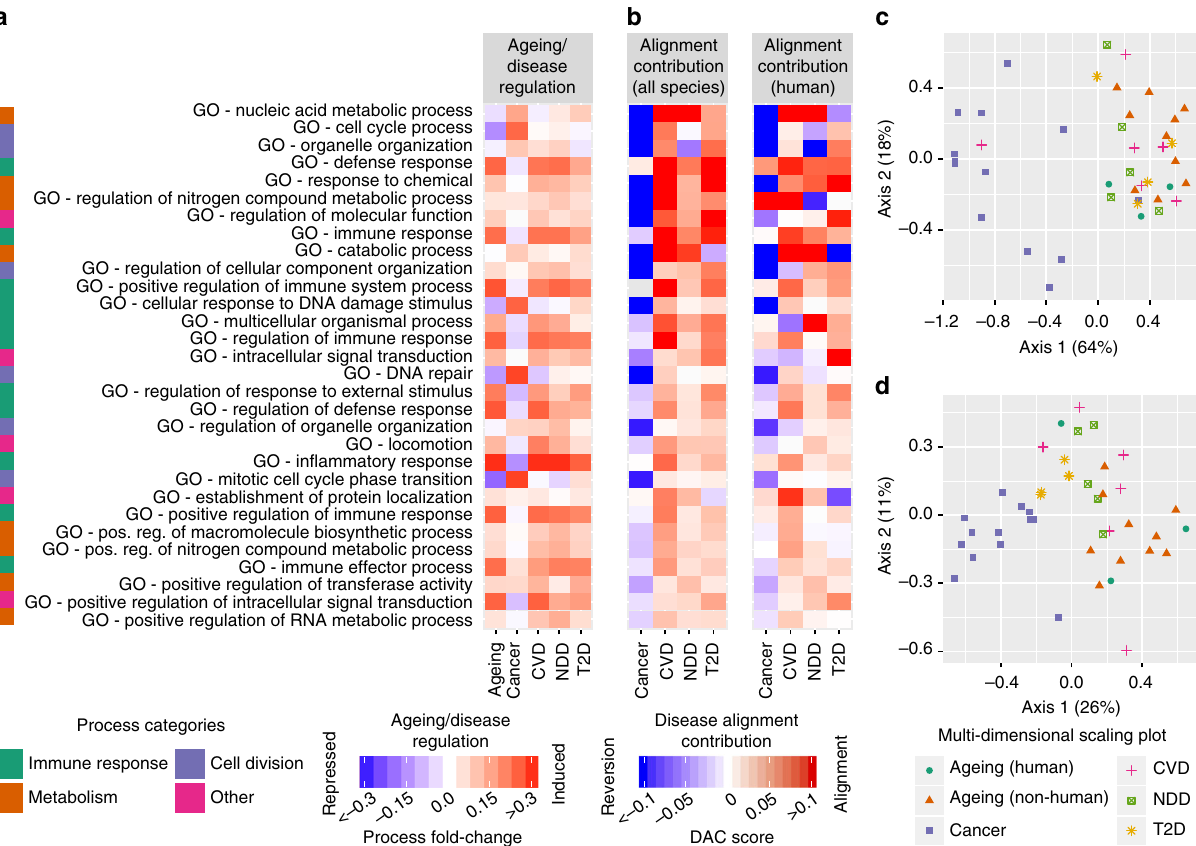
Fig. 4 Role of ageing-regulated processes in disease signature alignment. a For each process, mean foldchanges of genes belonging to that process in the ageing and disease data sets are shown. Processes are sorted by average absolute DAC scores . b DAC scores of 30 top scoring processes across the four major disease categories for all ageing data ( fi rst column) and for human ageing data solely (second column). c , d Multi-dimensional scaling plot of disease and ageing-associated gene expression changes based on ( c ) process foldchanges and ( d ) gene expression foldchanges. Each point corresponds to a condition (disease or ageing data set); distances indicate similarity in gene expression changes between conditions. Numbers in brackets denote the variance explained by each axis. Abbreviations: CVD cardiovascular diseases, NDD neurodegenerative diseases, T2D type 2